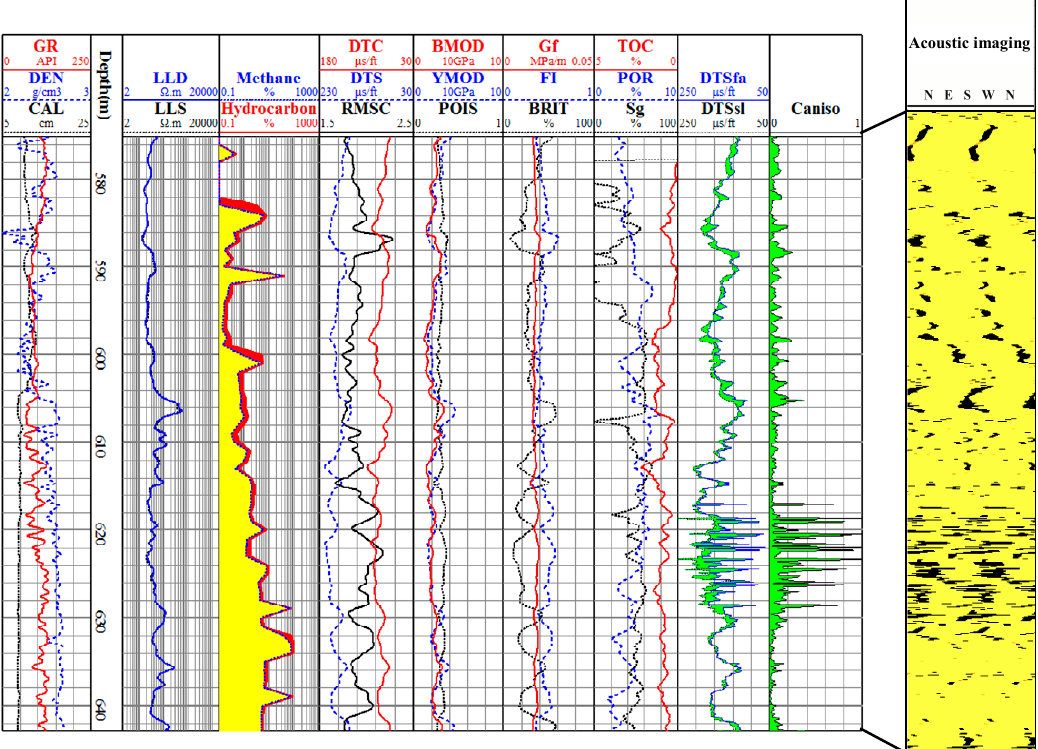
Figure 9. The presentation log of rock mechanics and dipole array acoustic anisotropy in Well A.